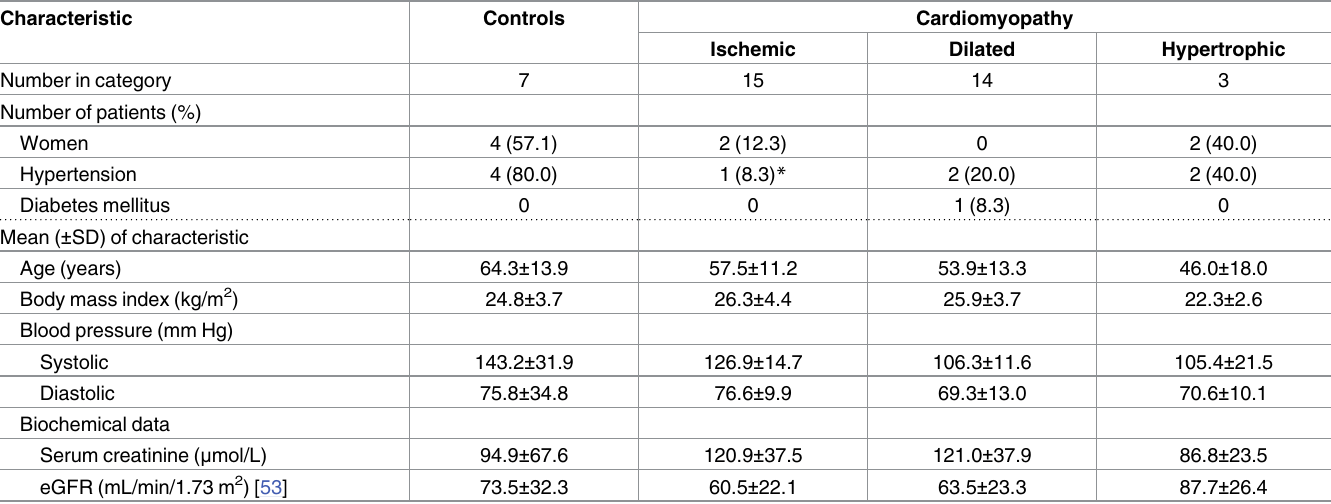
Table 3. Characteristics of cases and controls. Characteristic